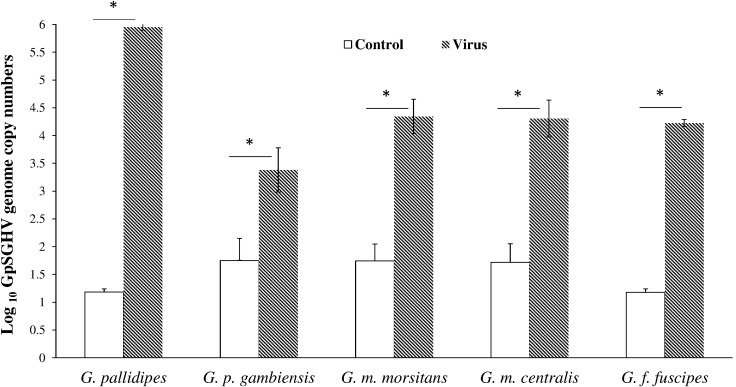
Viral copy numbers in conspecific Glossina species. Absolute viral copy numbers in the homogenates of the SGs dissected from 10-day old flies. These SG homogenates from the viremic flies were used to inject newly larviposited conspecific third instar larvae. ∗Indicate significant difference at the p = 0.05 level (Tukey HSD at the 95% family wise confidence level).